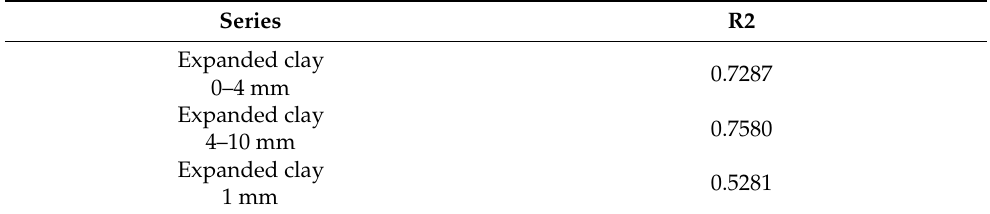
Table 4. Correlation coefficients for the polynomial correlation function.